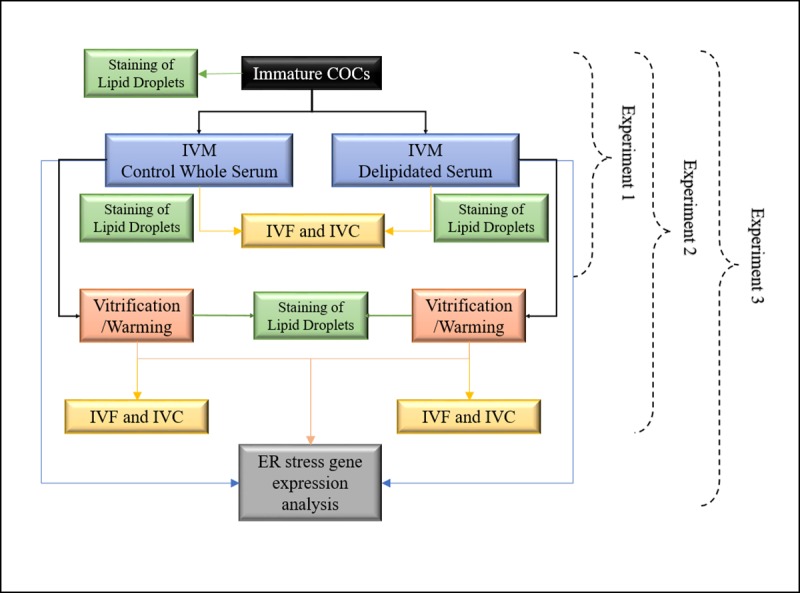
Experimental design.Schematic representation for determination of the effect of control whole estrous sheep serum vs. delipidated serum used during in vitro maturation of cumulus oocytes complexes (COCs) on oocyte lipid content and: embryo development (Experiment 1), cryotolerance after vitrification (Experiment 2), and expression of endoplasmic reticulum (ER) stress genes (Experiment 3).